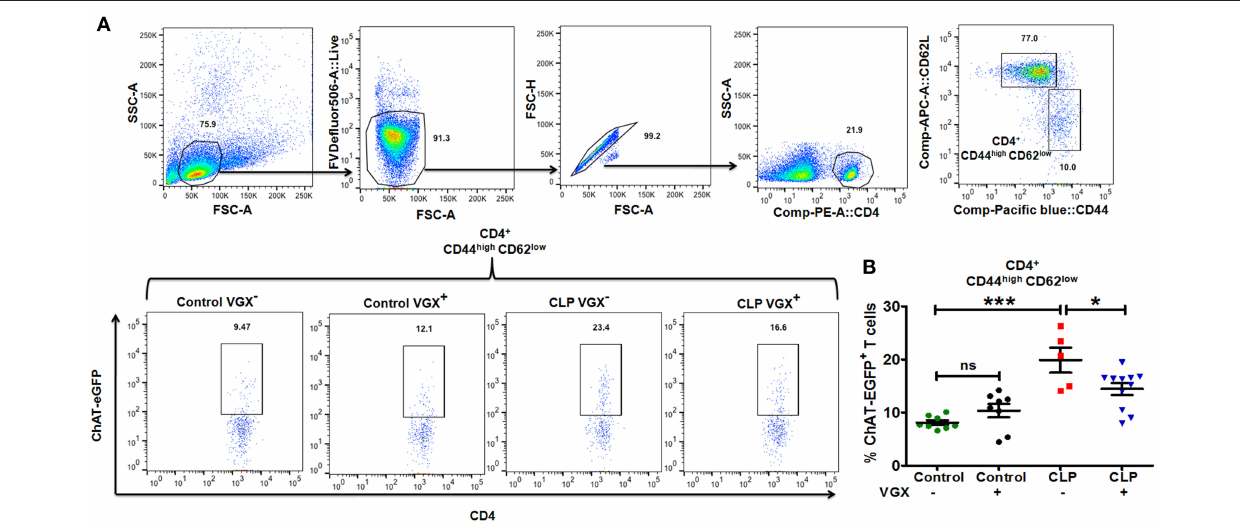
FIGURE 2 | Vagus nerve signaling increases the number of ChAT + memory T cells in CLP-survivors. To determine the number of ChAT + T cells, ChAT-EGFP mice were subjected to control or CLP surgery. Vagotomy was performed 2 weeks post control and CLP surgery. Splenocytes isolated from CLP or control mice at 4 weeks post-surgery were stained for CD4, CD44, and CD62L and analyzed by flow cytometry. (A) Representative dot plots depicting the gating strategy for splenic CD44 and CD62L expression in CD4 + T cells and ChAT-EGFP expression in CD4 + CD44 high CD62L low cells. (B) The percentage of ChAT-EGFP + cells among spleen CD4 + CD44 high CD62L low cells. Results represent the mean ± SEM of 5–11 mice per group from two independent experiments; CLP VGX − vs. CLP VGX + * p < 0.05; Control VGX − vs. CLP VGX − *** p < 0.001 and Control VGX − vs. Control VGX + ns = not significant (Tukey’s post hoc test).